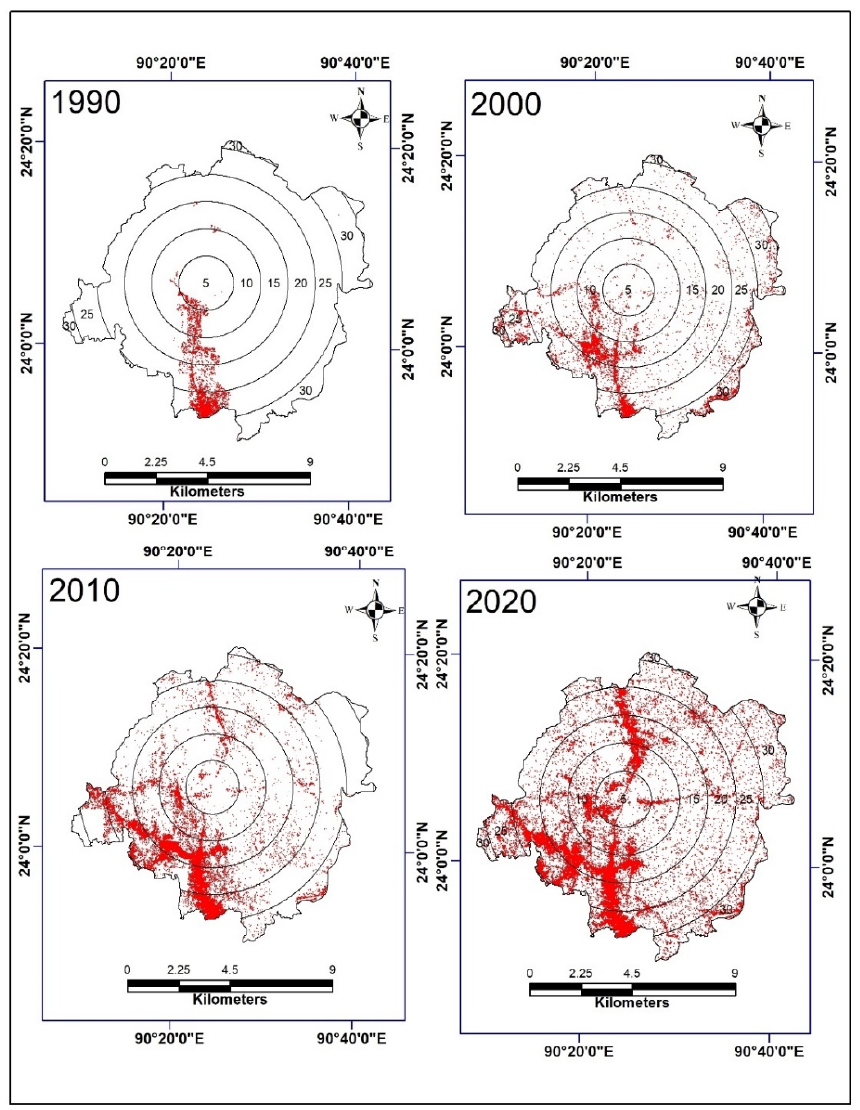
Figure 10. Assessment of built-up area by distance.